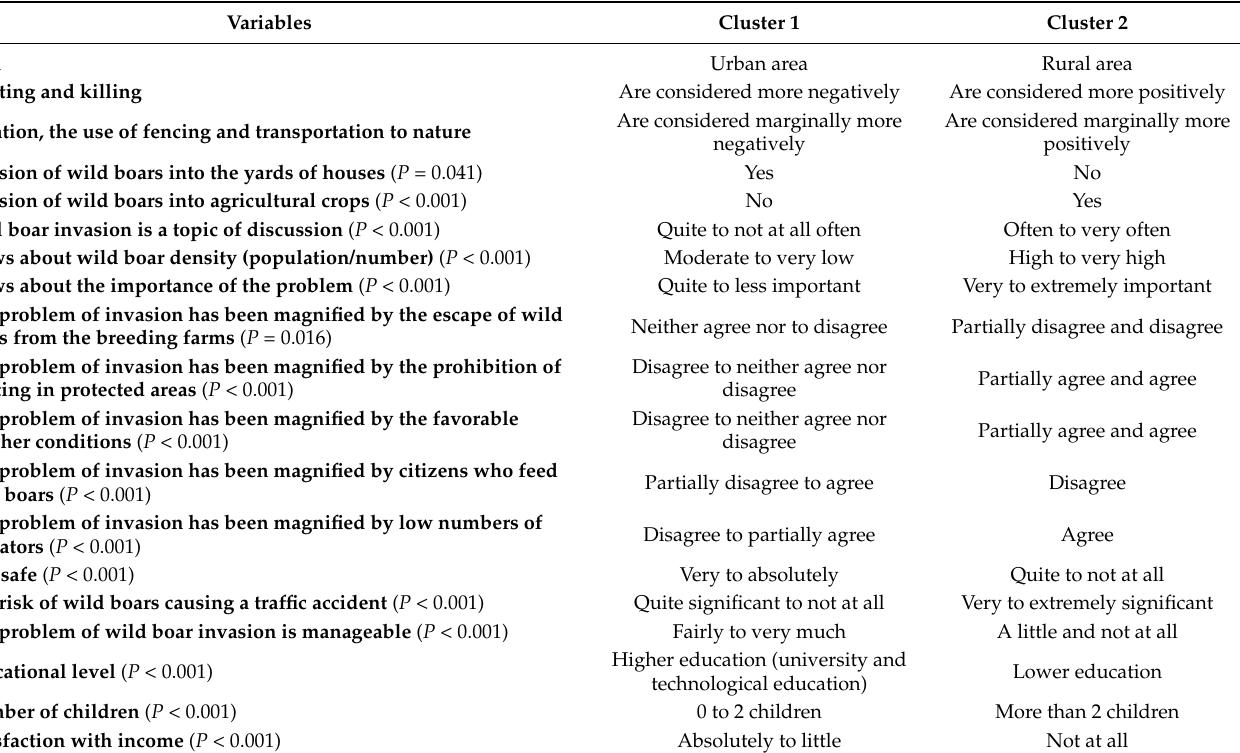
Table 3. Interpretation of the cluster